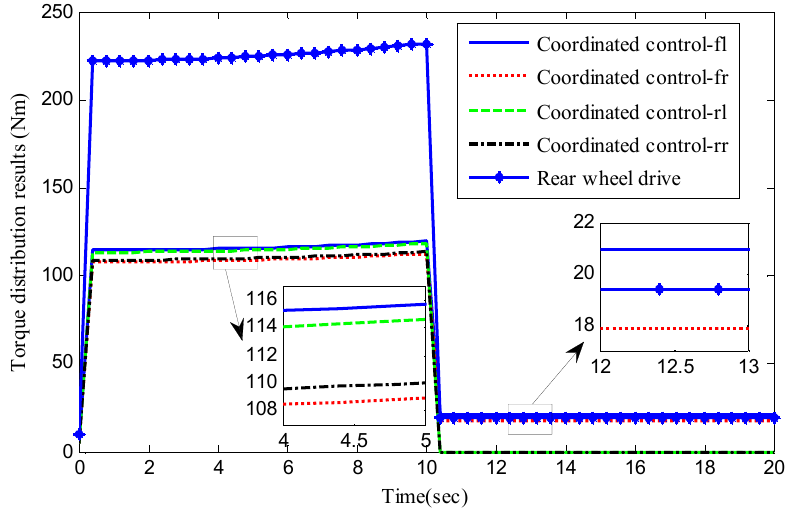
Figure 9. Torque distribution results in case study 1.